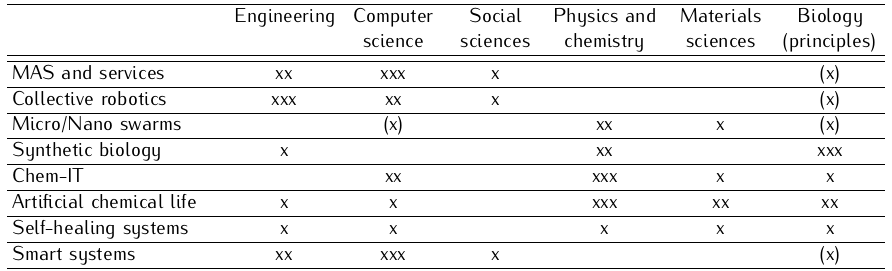
Table 1. Research areas in complexity engineering (rows) often include aspects from several fields (columns). Two or three marks indicate a strong contribution, whereas a single one stands for a weaker influence. A mark between brackets stands for the application of principles rather than using the actual substrate of the area. In some cases, such as self-healing systems, the contributions of the different fields depend on the individual